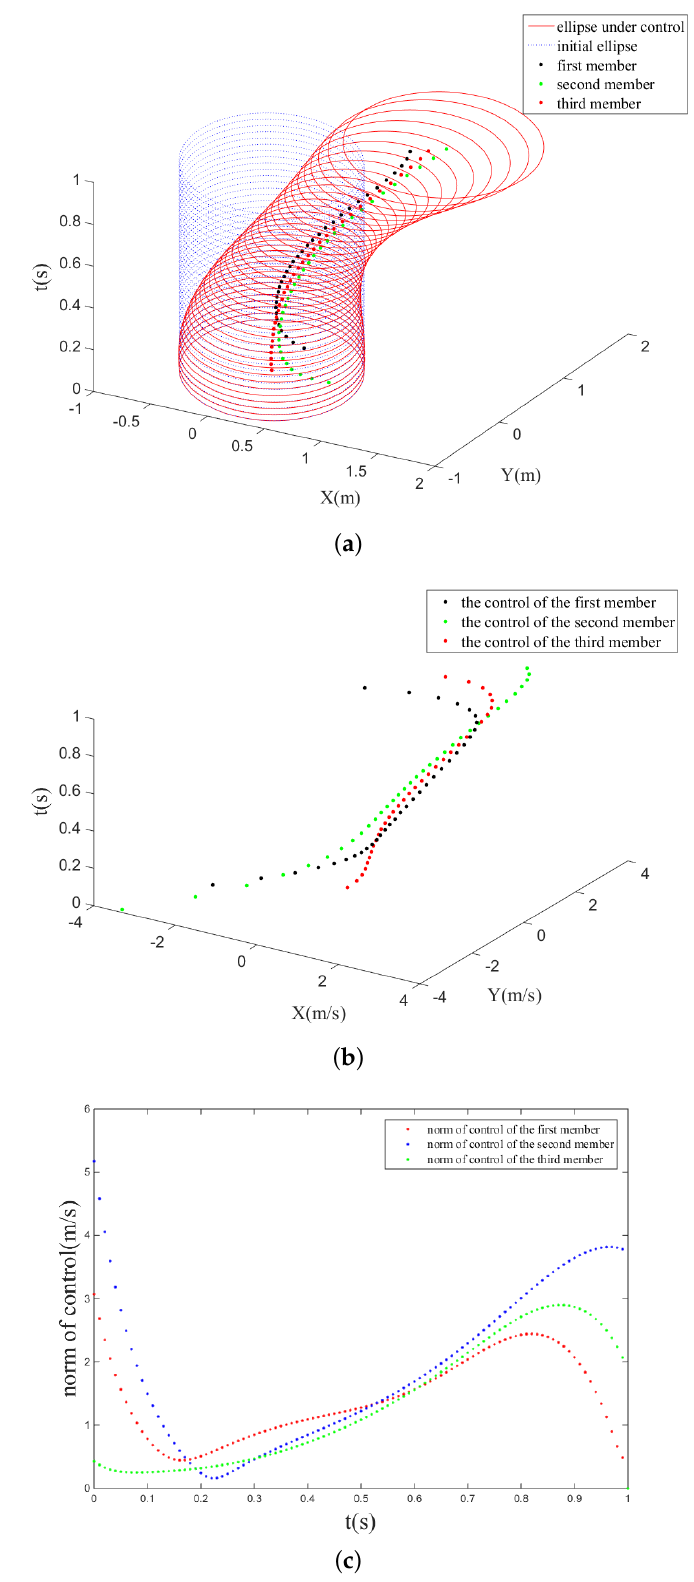
Figure 3. Team motion with initial states x 1 ( 0 ) = [ 0,0.5 ] , x 2 ( 0 ) = [ 0.5,0 ] , x 3 ( 0 ) = [ 0,0 ] and parameters ω = 0.1, β 1 = 5.87, β 2 = 5.88, β 3 = 5.85, κ 12 = 1.03, κ 13 = 1.05, κ 23 = 1.00. ( a ) The state-time relationship diagram of the cluster. ( b ) The control-time relationship diagram of the cluster. ( c ) The norm of the control-time relationship diagram of the